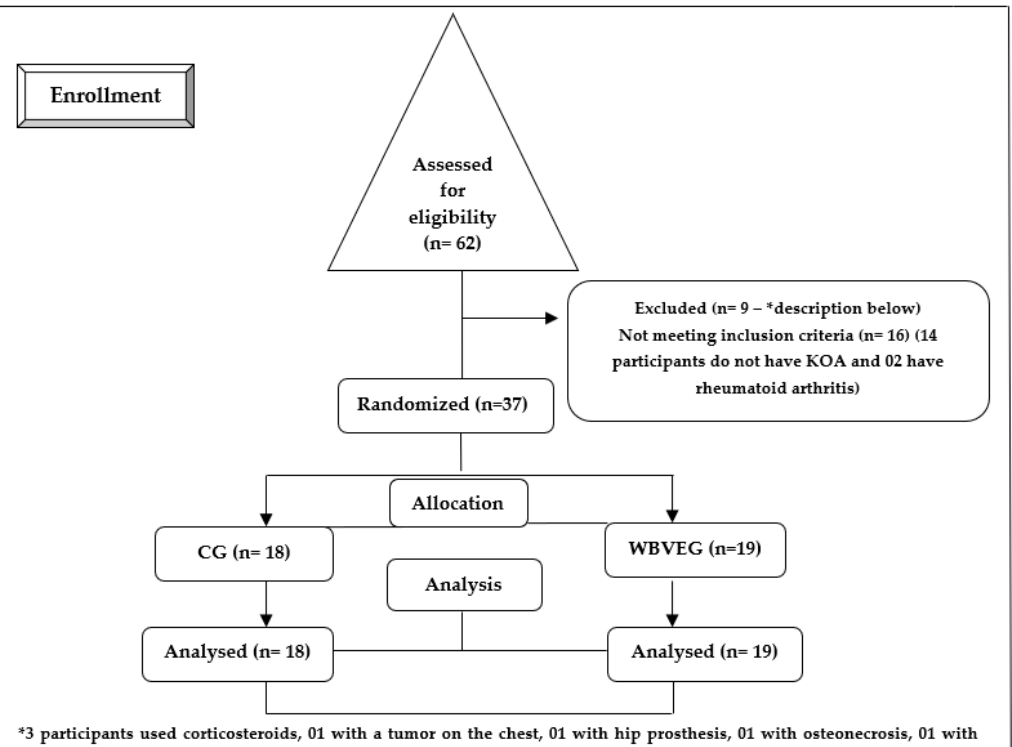
Figure 6. Flow diagram with the development of the study.